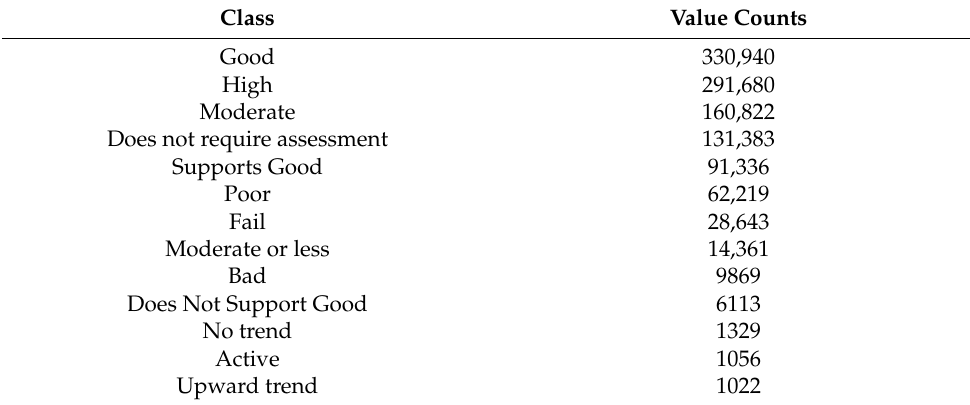
Table 2. “Status” column classes and their value